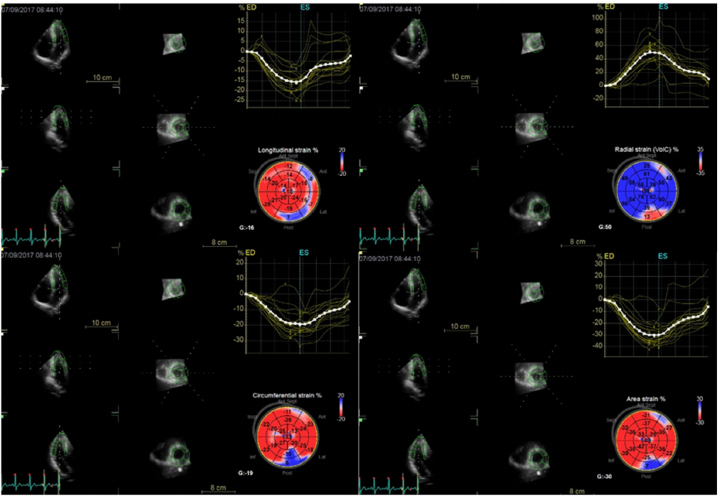
Fig. 1 - Three-dimensional speckle-tracking imaging of the left ventricle. EchoPAC software was used to trace the left ventricular endocardium and epicardial edge to obtain various three- dimensional strain indicators. ED=end-diastolic;